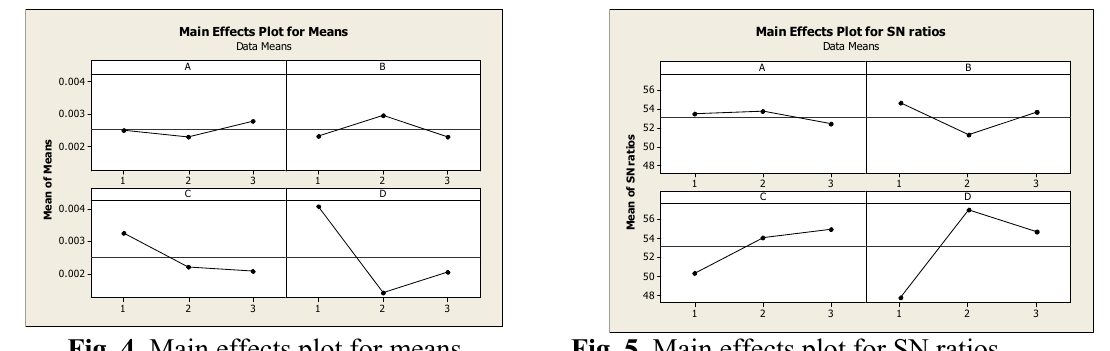
Fig. 4. Main effects plot for means Fig. 5. Main effects plot for SN ratios